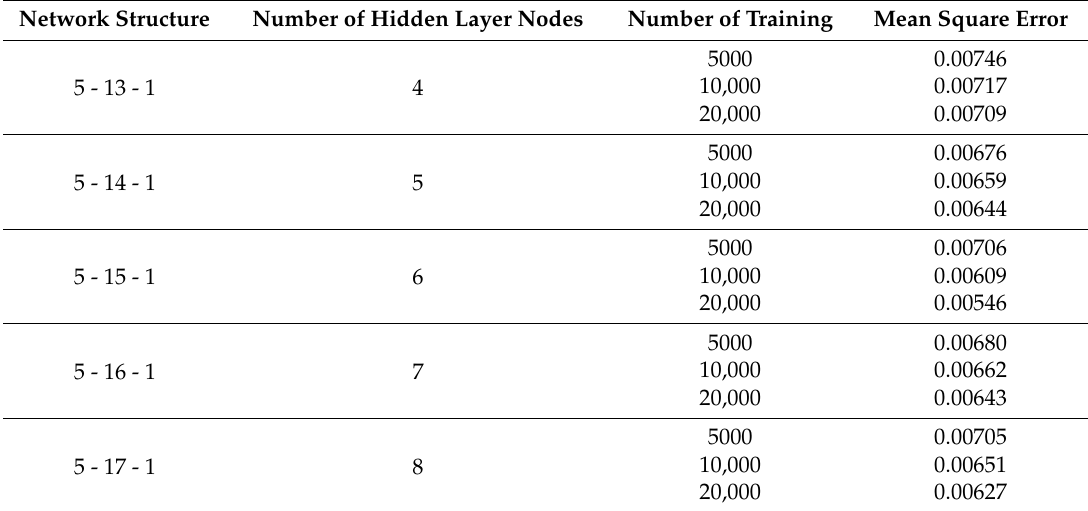
Table 3. Training results of the networks with different numbers of hidden nodes.